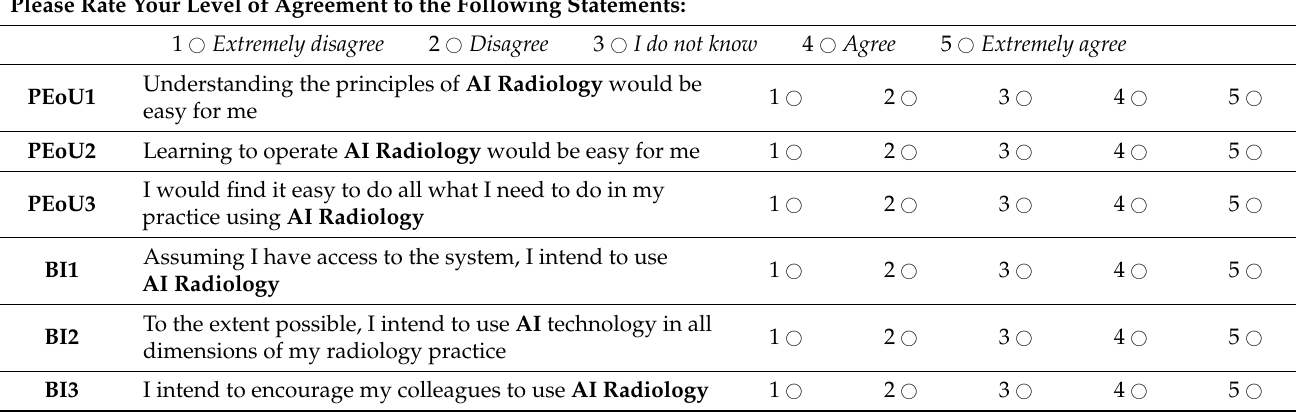
Table A4. Perceived ease of use and behavioral intention of Artificial Intelligence use in routine radiology